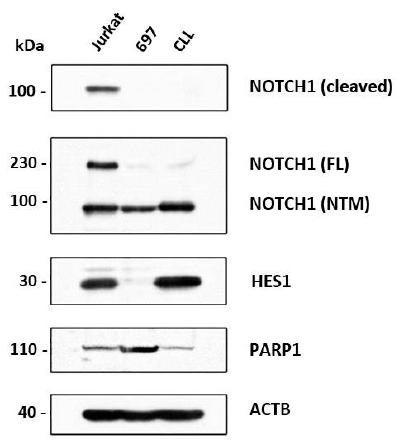
Figure 1. Characterization of the Notch signaling pathway in leukemic cells. Notch signaling activity in T cell line (Jurkat), B chronic lymphocytic cell line (CLL) and B cell precursor leukemia cell line (697) was analyzed by Western blot. FL: full-length; NTM: transmembrane/intracellular region; ACTB: β -actin. Next, we analyzed cell proliferation and cytotoxicity in cells treated with different concentrations cytotoxicity in any of three cell lines, except B CLL line showing decreased proliferation after six days